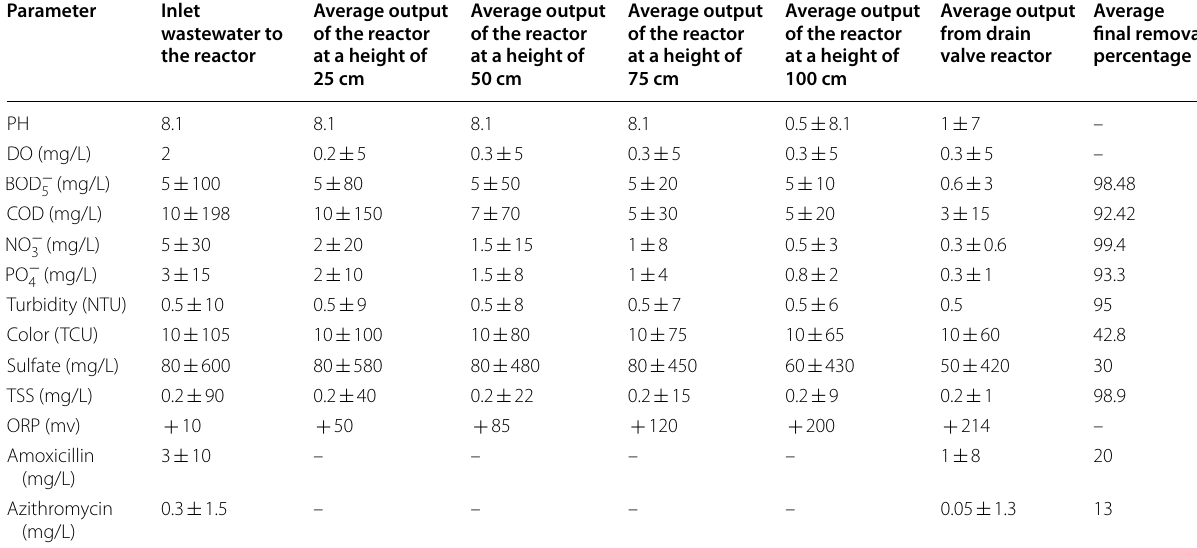
Table 5 Results of biological filtration by date kernels Parameter